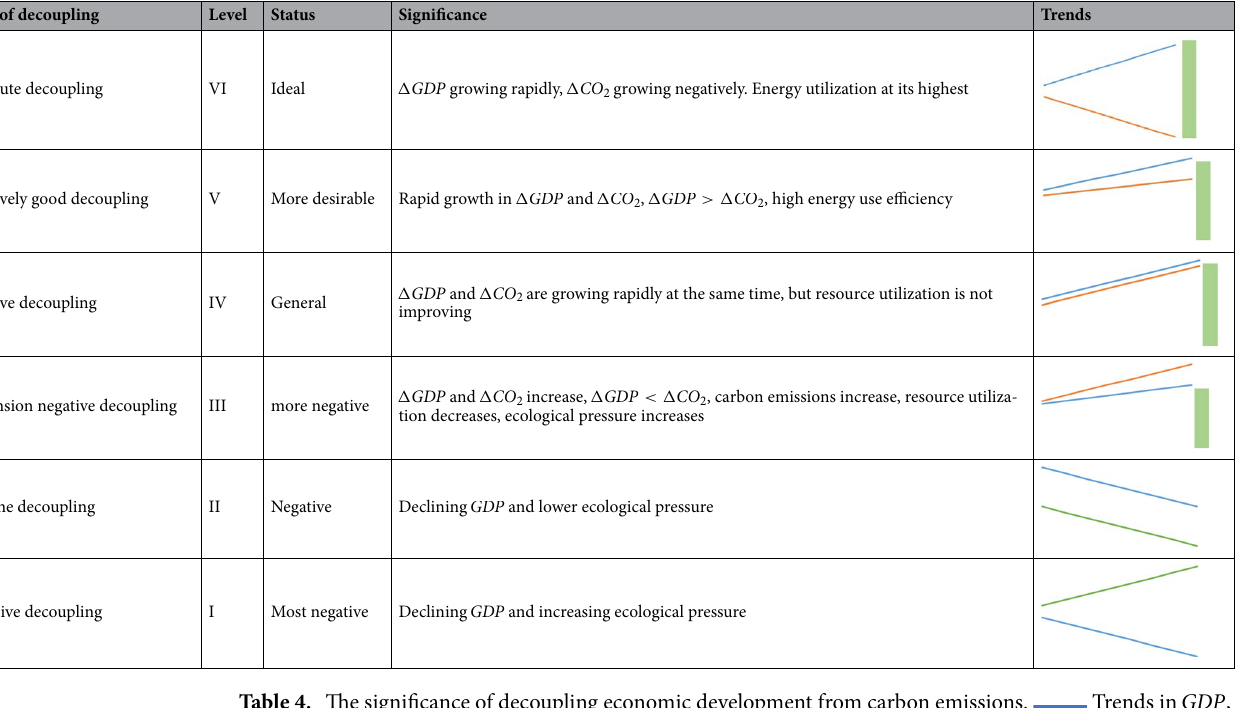
Table 4. The significance of decoupling economic development from carbon emissions. Trends in GDP , Trends in carbon emissions, Trends in ecological pressures, Resource utili-zation.